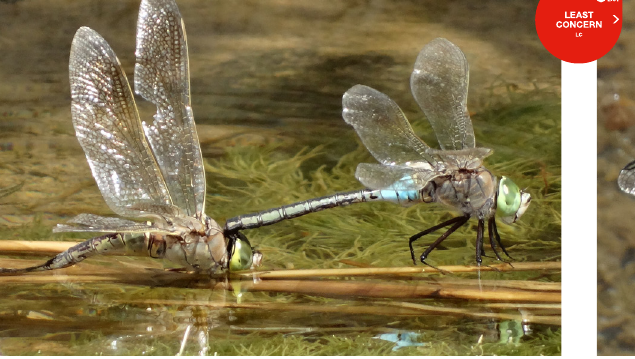
Image 11. Male Paragomphus genei , 5 May 2014. Greenish-blue eyes, green thorax with narrow brown lines, straw and sandy coloured abdomen with brown and black markings and hooked terminal appendages. Dark pterostigmas with light centre